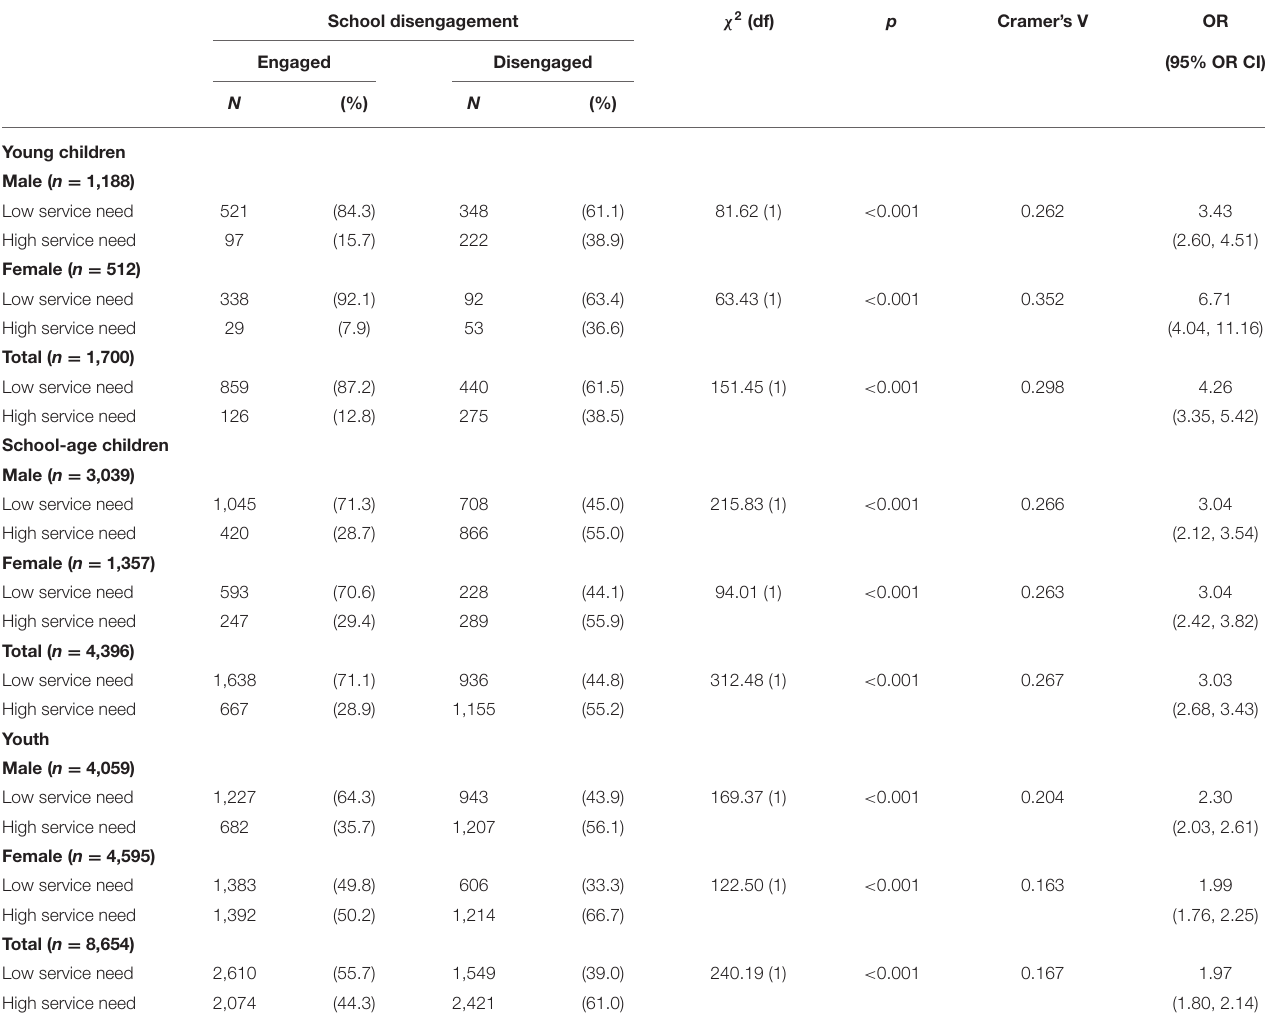
TABLE 2 | Chi-square comparison of service intensity need and risk for school disengagement by sex and age. School disengagement χ 2 (df) p Cramer’s V